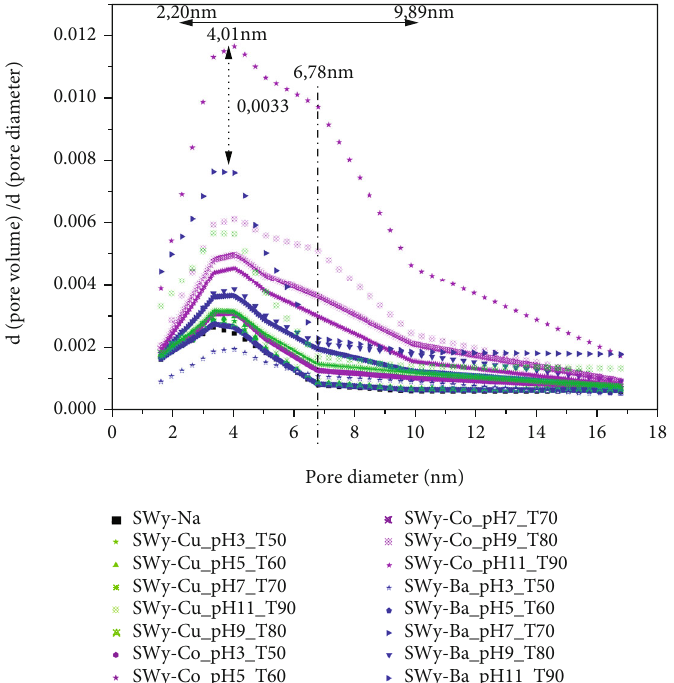
Figure 16: The derivative pore size distribution